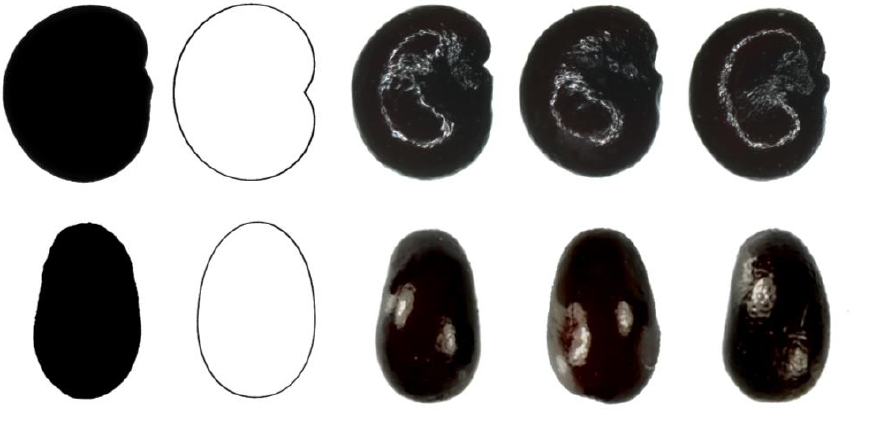
Figure 10. Silene baccifera : average silhouettes (left), the models giving best scores with 20 seeds (LM4 and DM3), and three representative images for the lateral (above) and dorsal (below) seed views. Bar represents 1 mm.